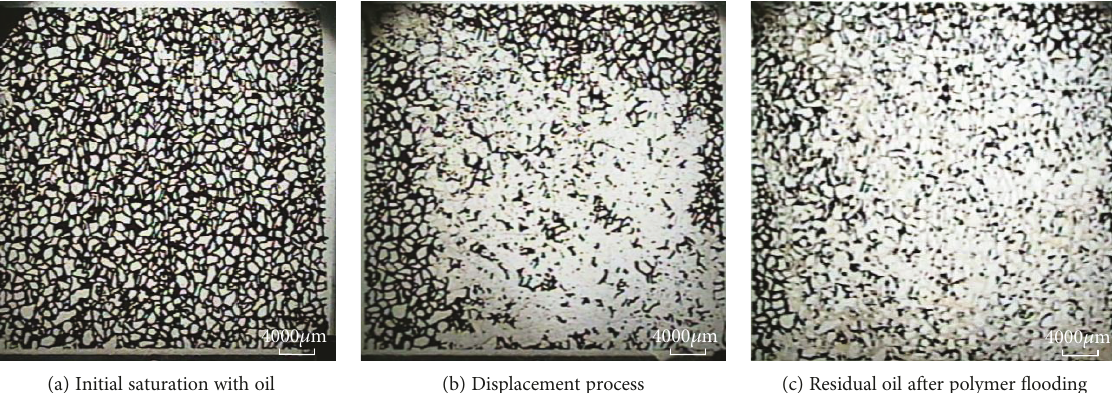
Figure 6: Oil distribution with viscoelastic polymer fl ooding in a simulation model (the dark area is oil, and the lighter the color is, the lower the saturation is; the light area represents the displacing fl uid).